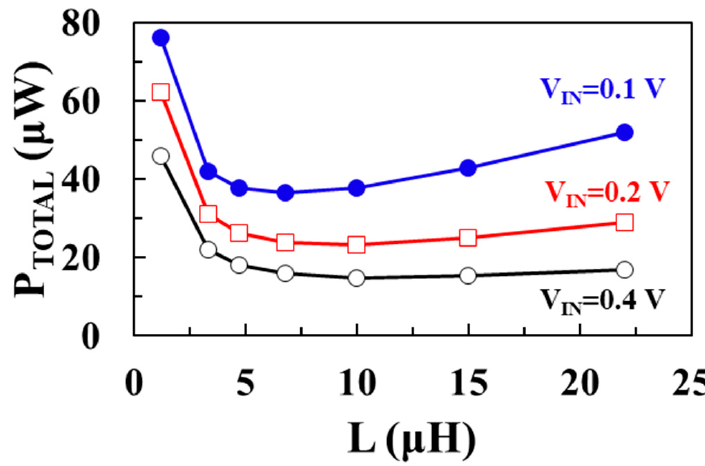
Figure 8. Modeled total loss according to inductance for different input voltages.